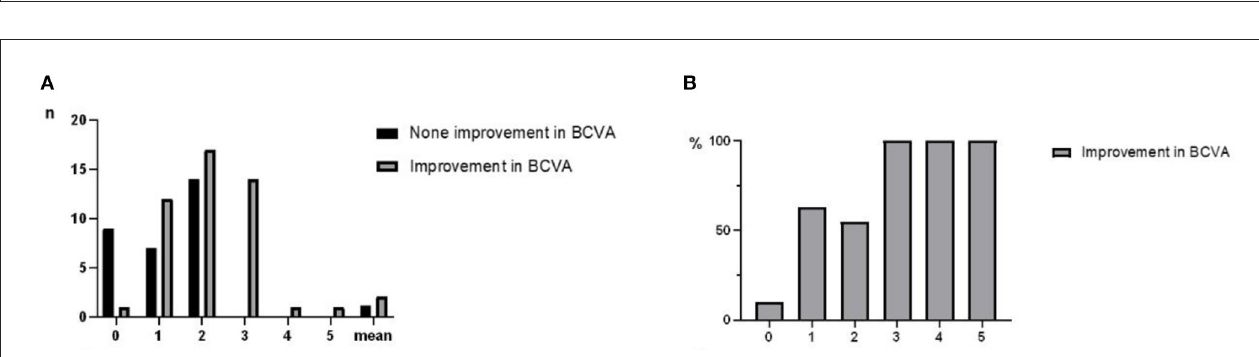
showed improvement after surgery had an average of 2.11 times model, the area under the curve (AUC) = 0.7596, specificity = 0.6250, and sensitivity = 0.7692. The nomogram of this model is shown in Figure